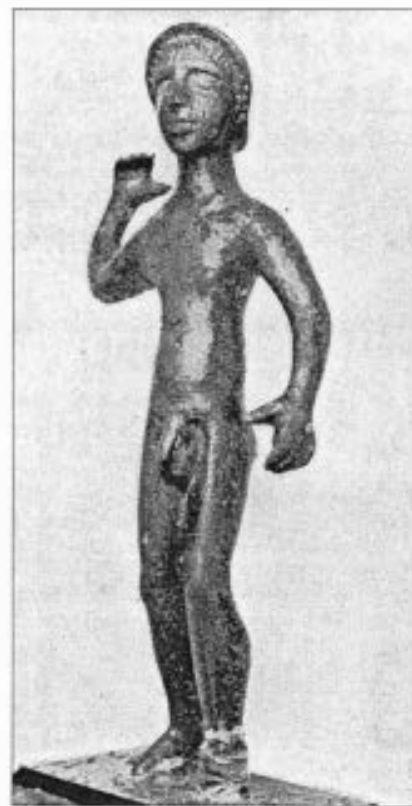
Figure 5 Bronze figurine of a warrior ( 15.5 cm high) from Lagole (fourth century BC). The inscription runs down the back of the raised arm, across the shoulder and down the side of the figure, and reads Bro­ ijokos donom doto Sainatei Trumusijatei ("Broijokos gave this gift to Sainatei Tru­ musiatos" or "Broijokos gave this gift to Sainatei Trum usiata